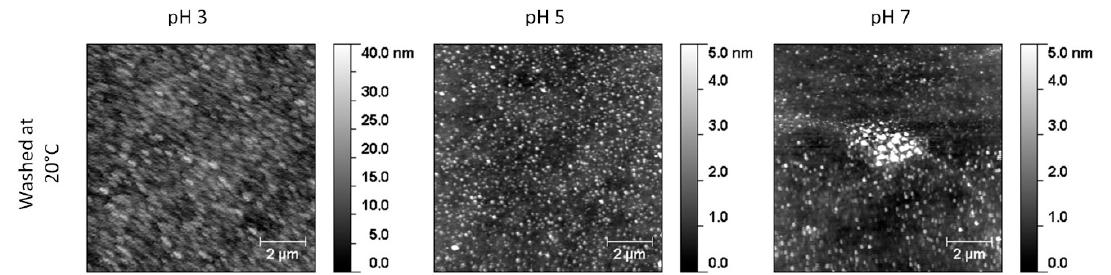
Figure 6. AFM images of PNIPAm b films spin-coated on glass-OH, glass-TMSPMA and glass-TMOS at 5000 rpm from a dispersion of 3 wt%, after being washed in water at 20 °C.